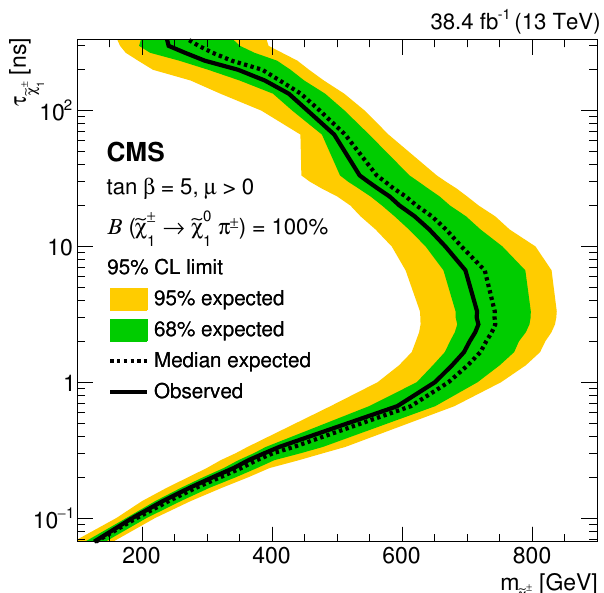
Figure 4 . The expected and observed constraints on chargino lifetime and mass. The region to the left of the curve is excluded at 95% CL.